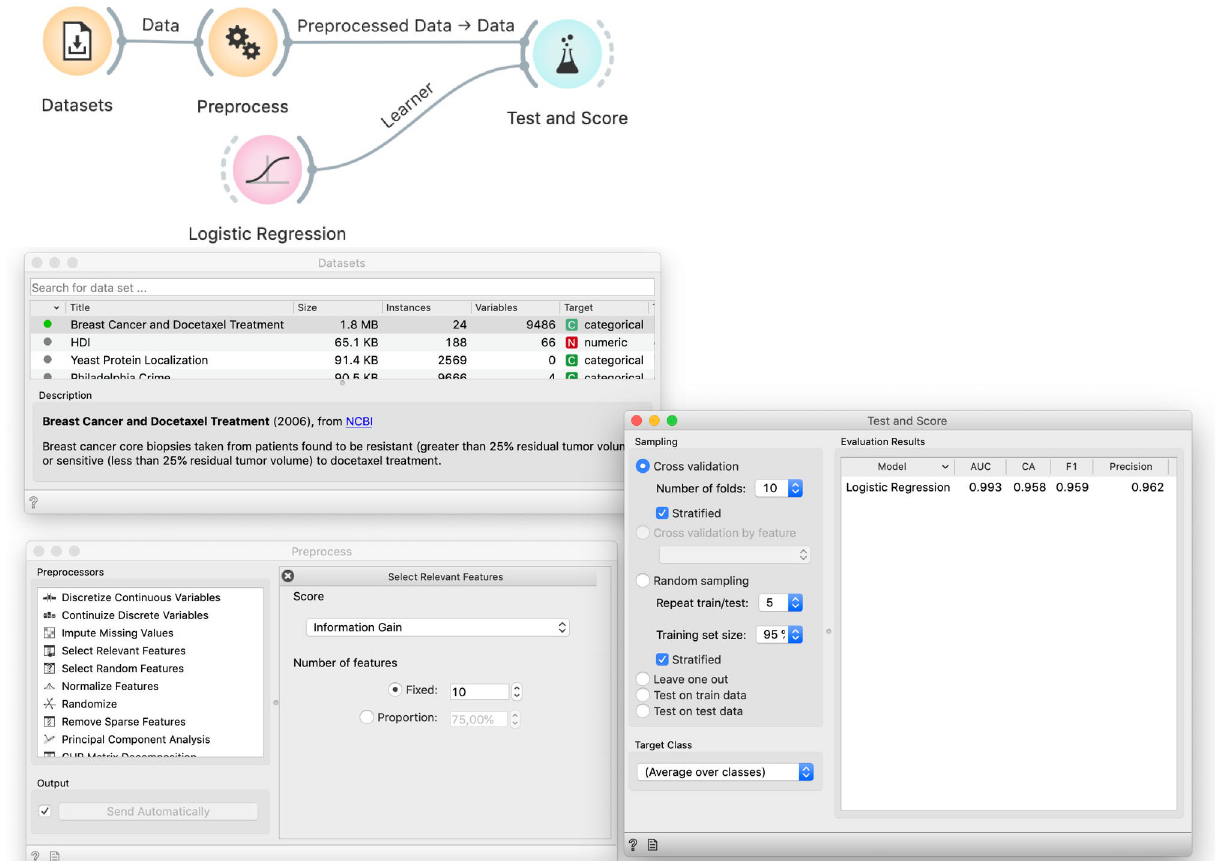
Fig 7. Improper way to select features. The Dataset widget loads the data from our curated repository of data sets. The Preprocess widget selects ten most informative features. This data is used to cross-validate logistic regression, which achieves a 96% classification accuracy.